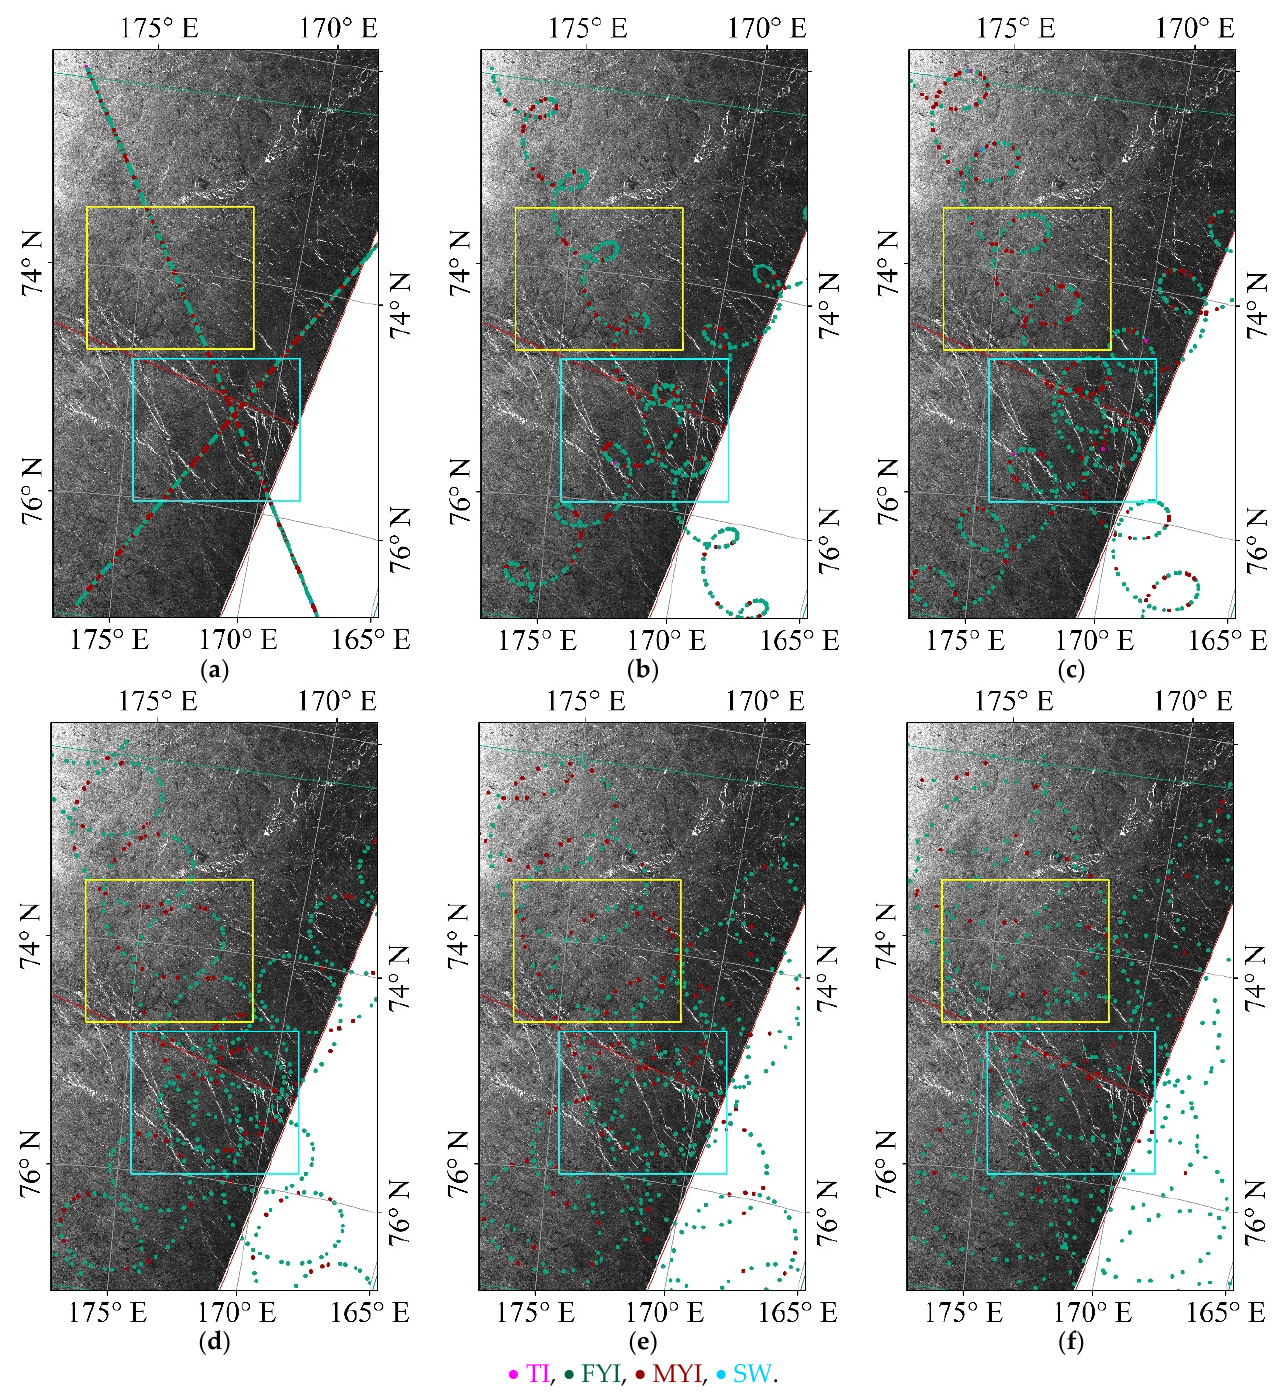
Figure 15. Classification results in two Sentinel-1 SAR images of FYI on 19 January 2020. ( a ) 0°; ( b ) 2°; ( c ) 4°; ( d ) 6°; ( e ) 8°; ( f ) 10°.